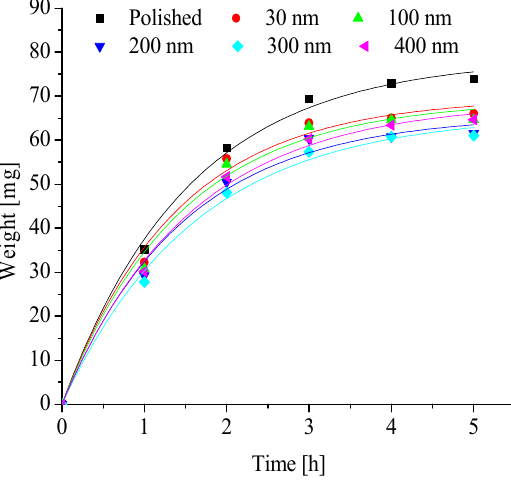
Figure 28. Testing value exponential model regression fitting at T = − 10 °C, φ = 90%.